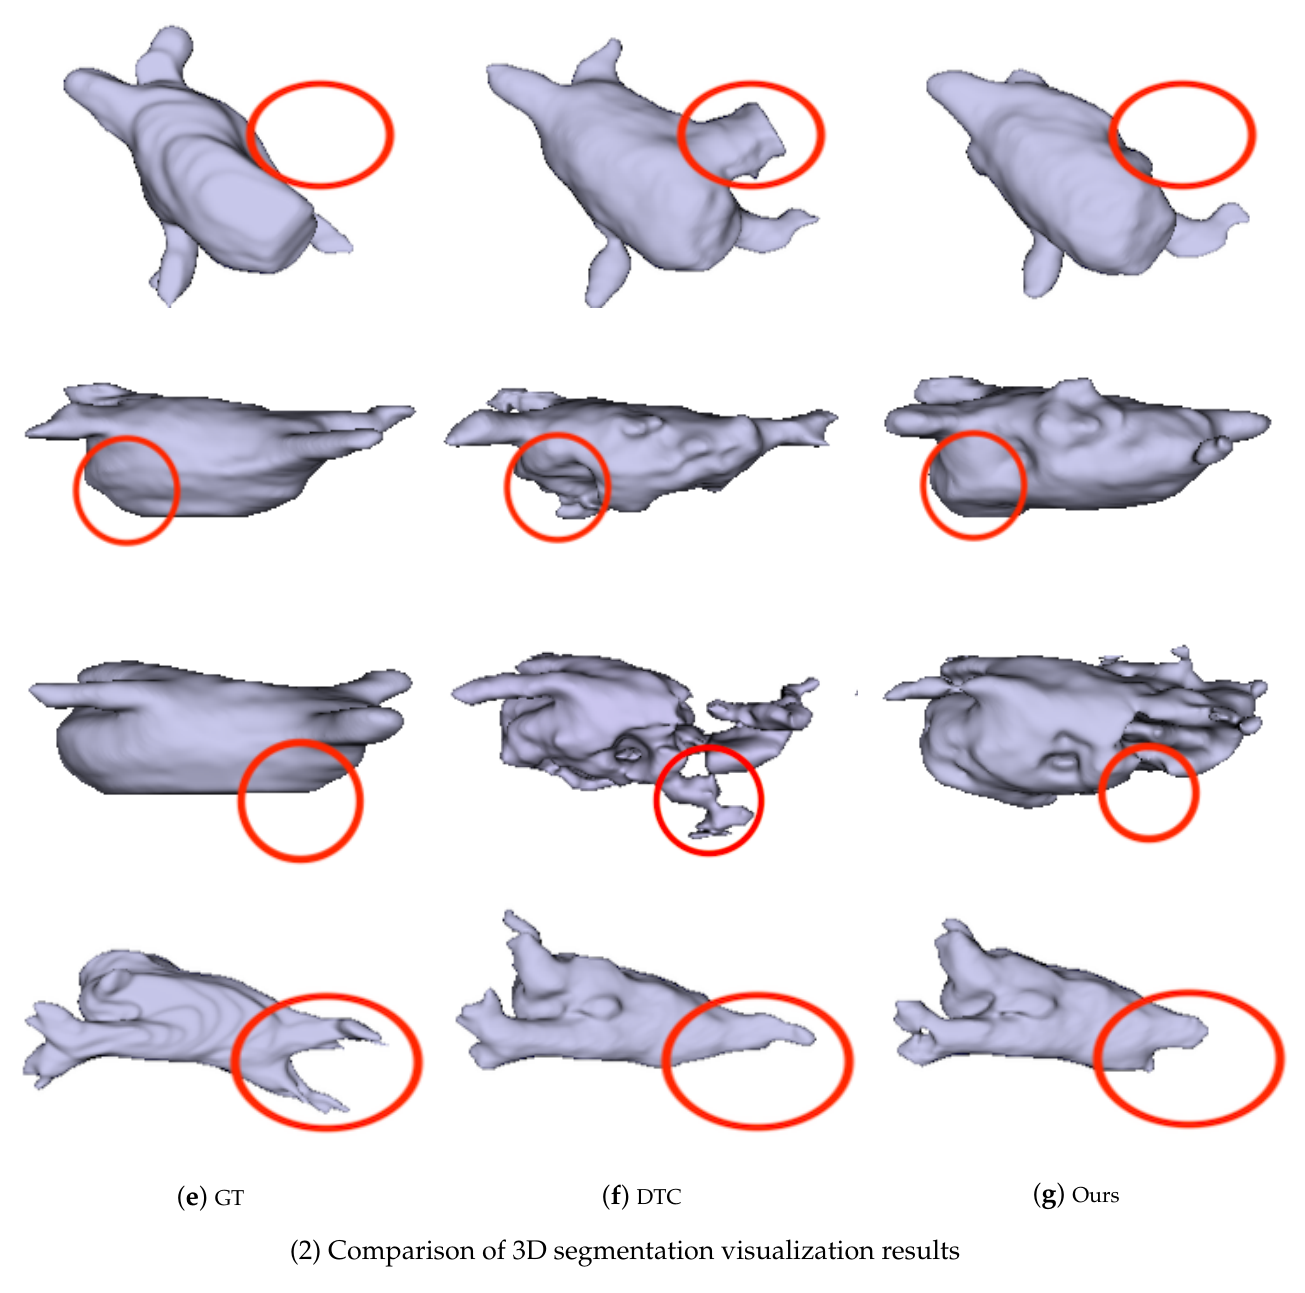
(2) Comparison of 3D segmentation visualization results Figure 3. 2D and 3D Visualization of the segmentation by DTC [9] and our method, where GT denotes ground truth segmentation.